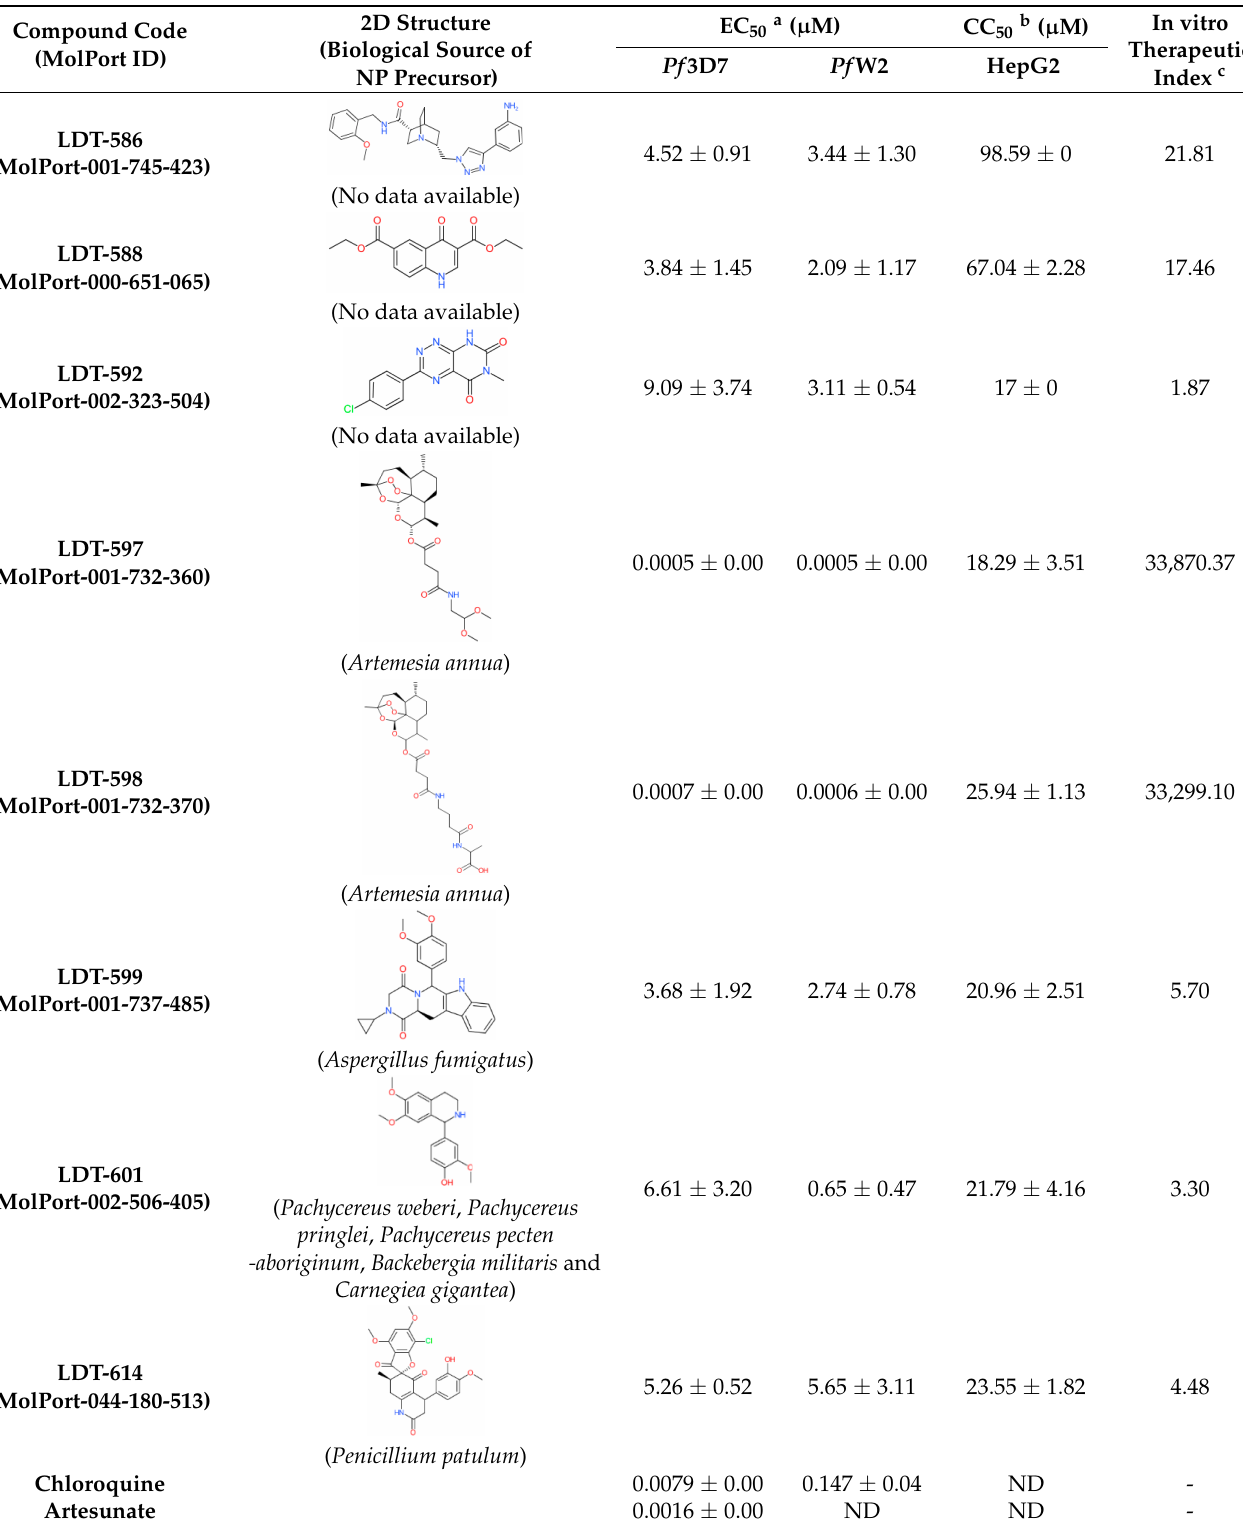
Table 1. The most promising compounds predicted to be active against P. falciparum asexual stages selected by virtual